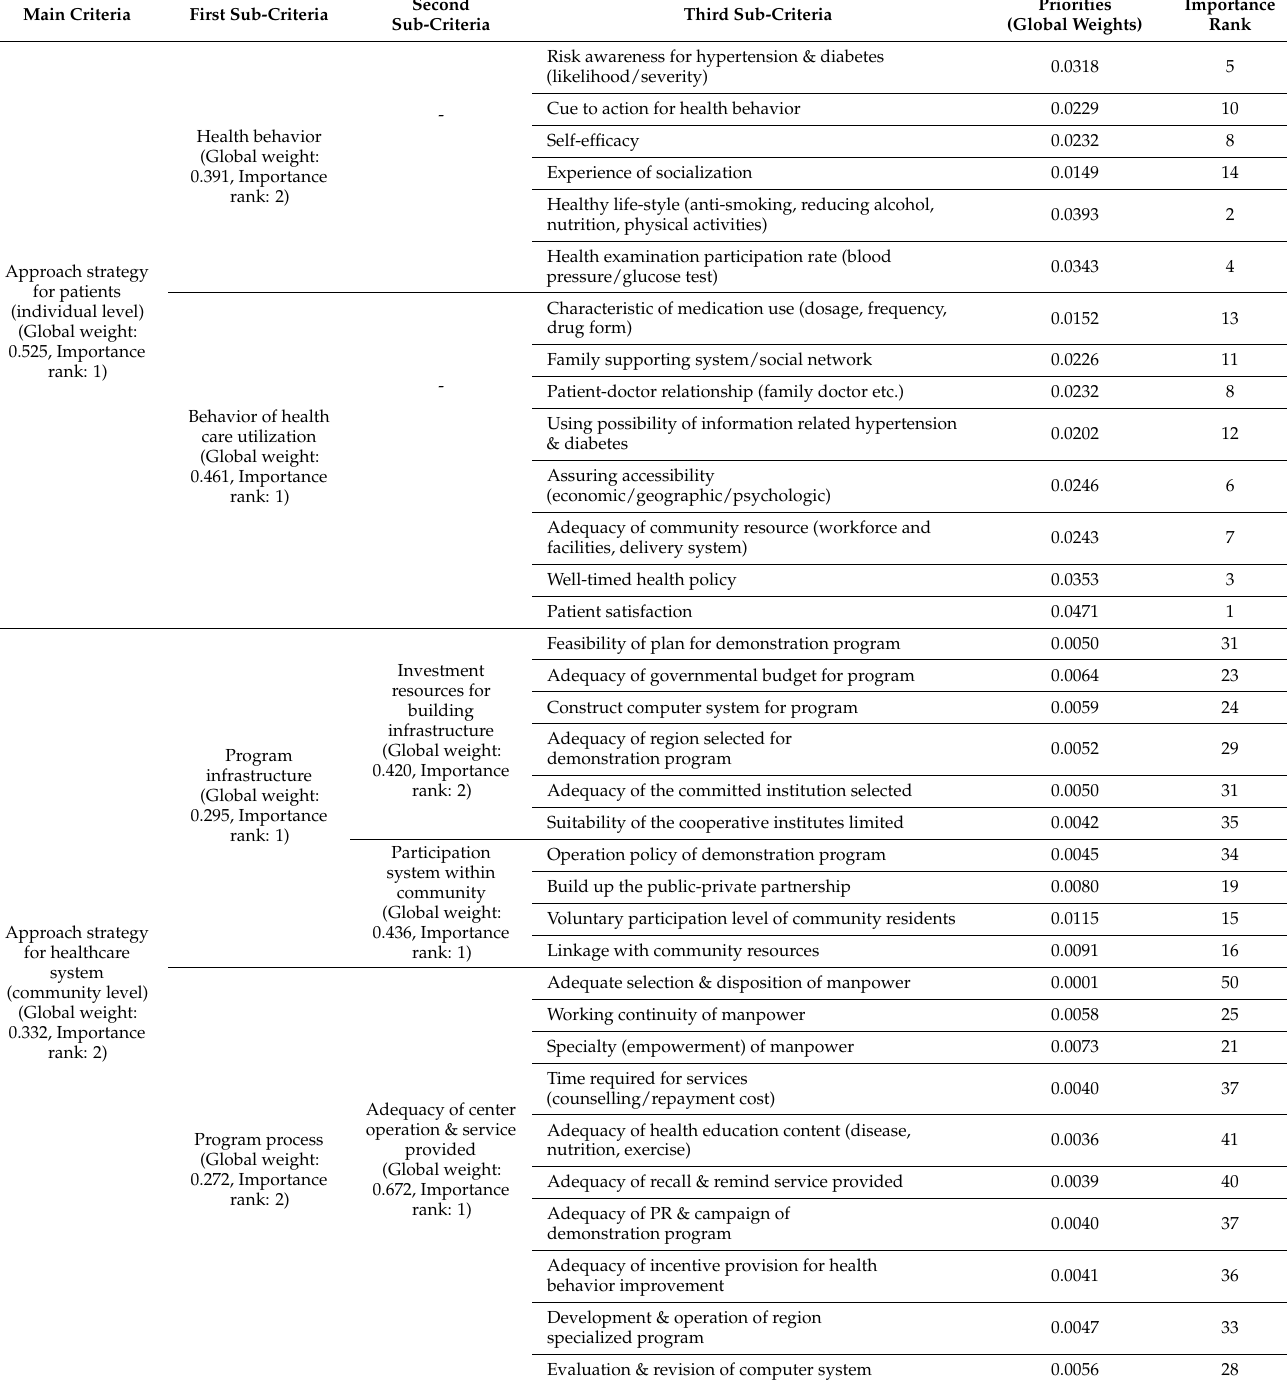
Table 4. Priority by each evaluation criteria for community-based intervention program with pairwise comparison. Main